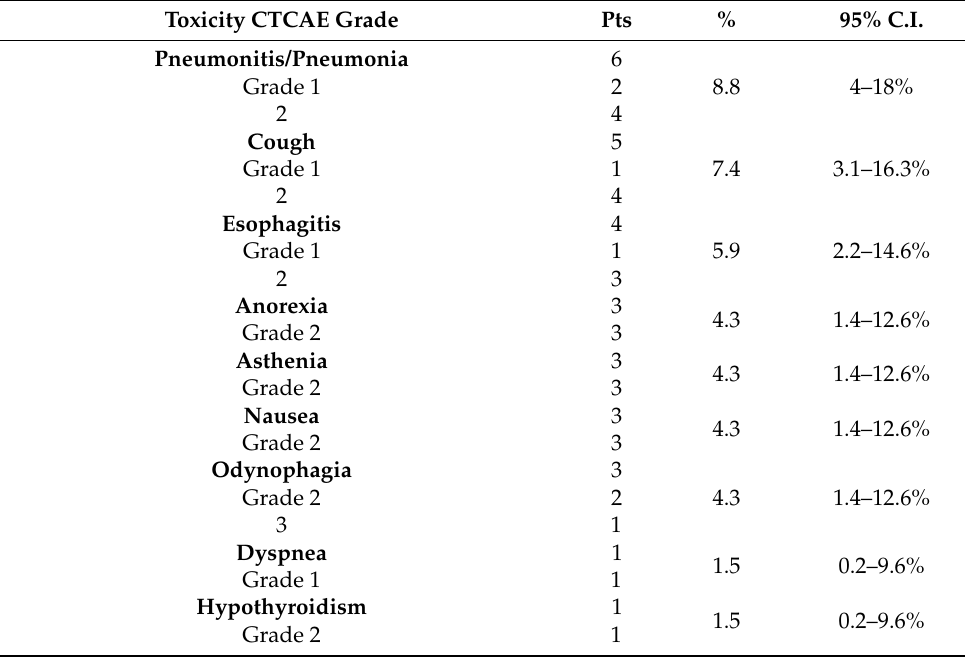
Table 4. Clinical toxicity—incidence and grade in 68